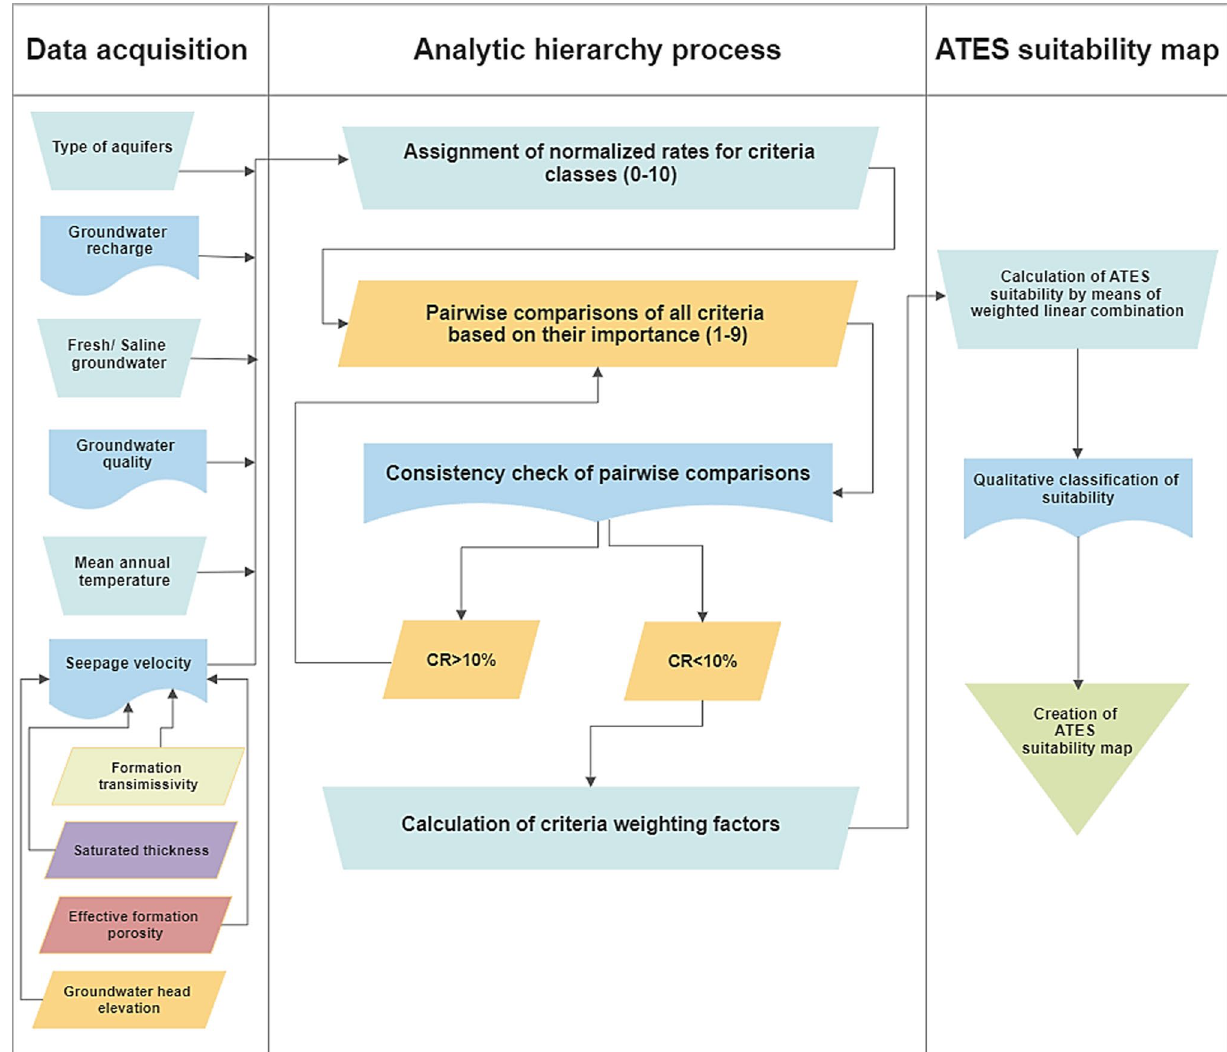
Fig. 2 Flowchart of creating the ATES suitability map in the Halabja-Khurmal